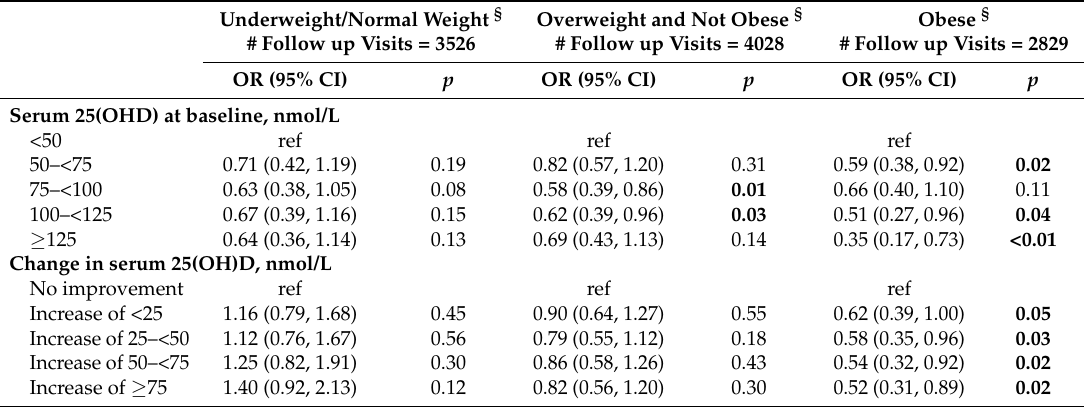
Table 3. Risk for elevated C-reactive protein concentration ( ≥ 1 mg/L) at follow-up by body weight